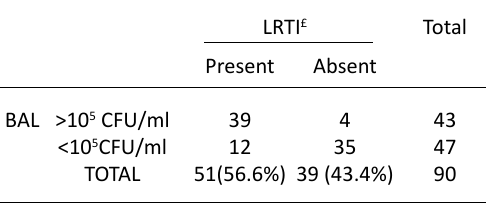
table 2. Contingency table – BAL Quantitative culture with LRTI {Total microbial isolation= 39(43.3%)}